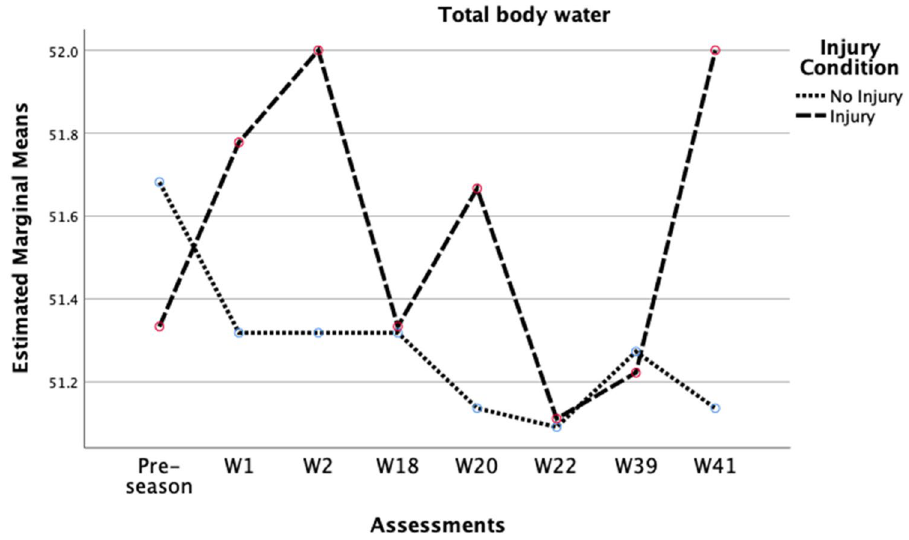
Figure 3. Variation in players’ total body water across the season 2020/2021.